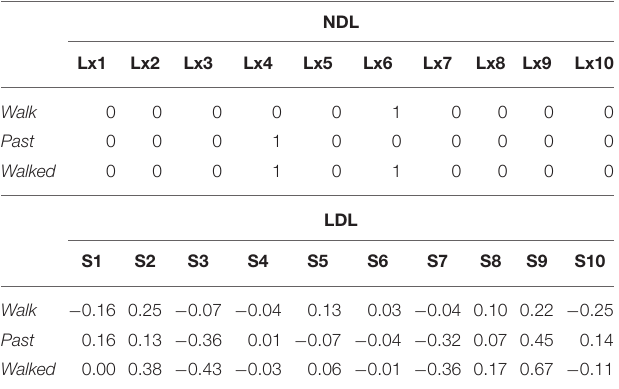
TABLE 3 | Semantic vector representations for inflected words in NDL (top) and LDL